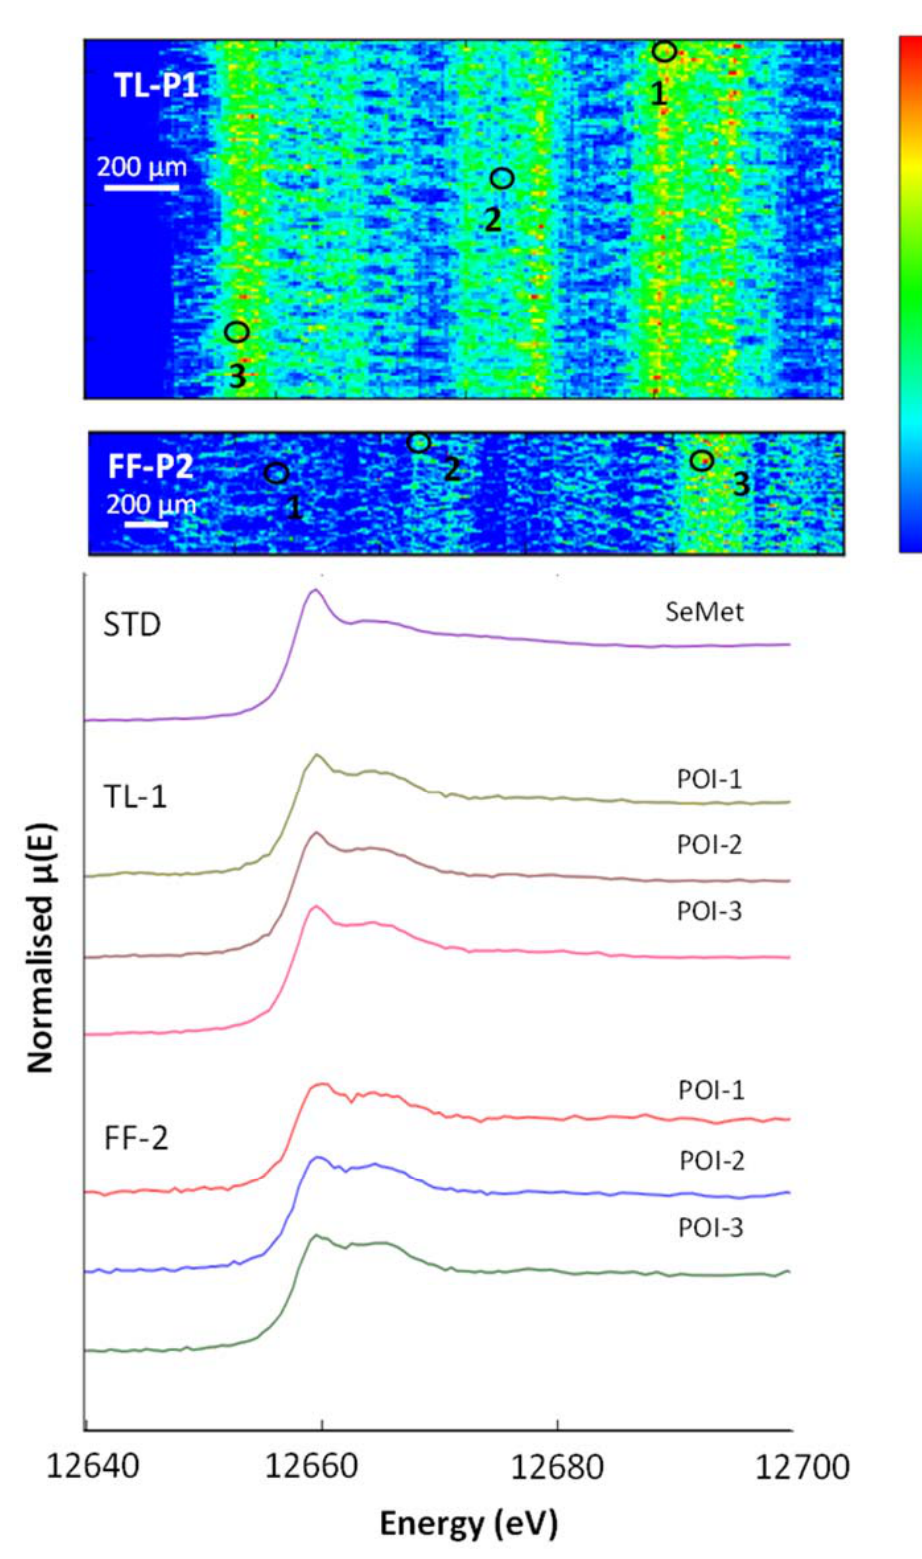
Figure 7. ( Top ): µ -XRF Se K -edge maps showing a grass leaf (shoot) from sites TL-P1 and FF-P2. The µ -XRF is on a temperature scale, with high selenium counts in red and areas with no counts in dark blue. ( Bottom ): normalised XANES spectra showing selenium species in selected POIs and the SeMet standard.